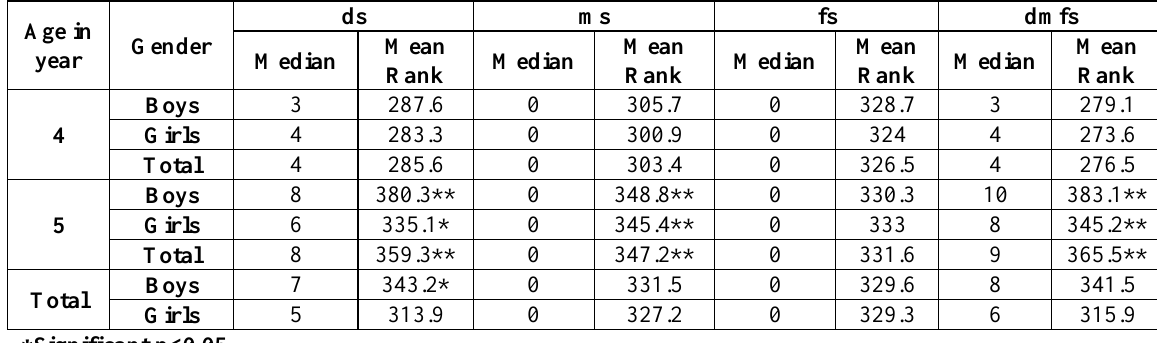
Table 3: Caries experience (Median, Mean Rank of ds, ms, fs, dmfs) among children by age and